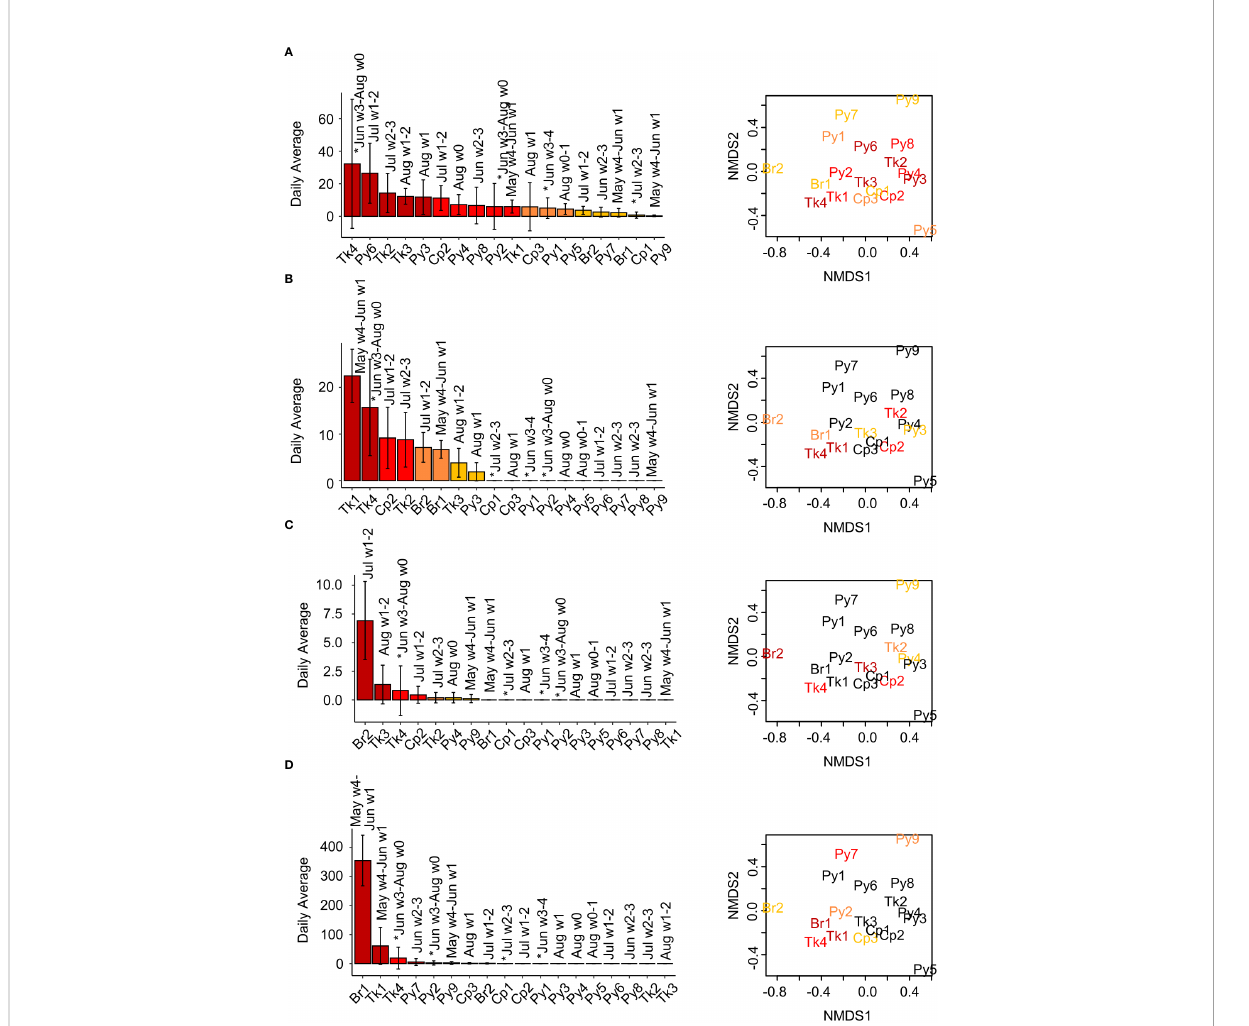
FIGURE 7 Daily call rates (average ± SD) among reefs and call rate associations with fi sh species abundance and composition. (A) Thud sound, (B) knock- train sound, (C) Harmonic sound, and (D) leopard toad fi sh boatwhistle call rates. (B) Daily averages of knock-trains come from accidental detections using a custom routine intended to detect thud sounds. Month and week number (1-4) of the month the reef is sampled are indicated above the bars. Reefs sampled in 2018 are indicated on the month of sampling with an asterisk. nMDS plots of (dis)similarity of fi sh species presence/absence among reefs based are shown right (stress = 0.166), with reef abbreviations in colors indicating reefs in which this sound type was detected. Plots are repeated for each row (sound type) with colors assigned for that sound type. Colored bars and text from dark red to yellow indicate the relative call rates among reefs with > 0 calls, from high to low. Dark red = call rates in 100-75 th percentile, red- orange = call rates from 50-74.9 th percentile, orange = call rates from 25-49.9 th percentile, yellow = call rates from 0-24.9 th percentile, black = no calls detected on that